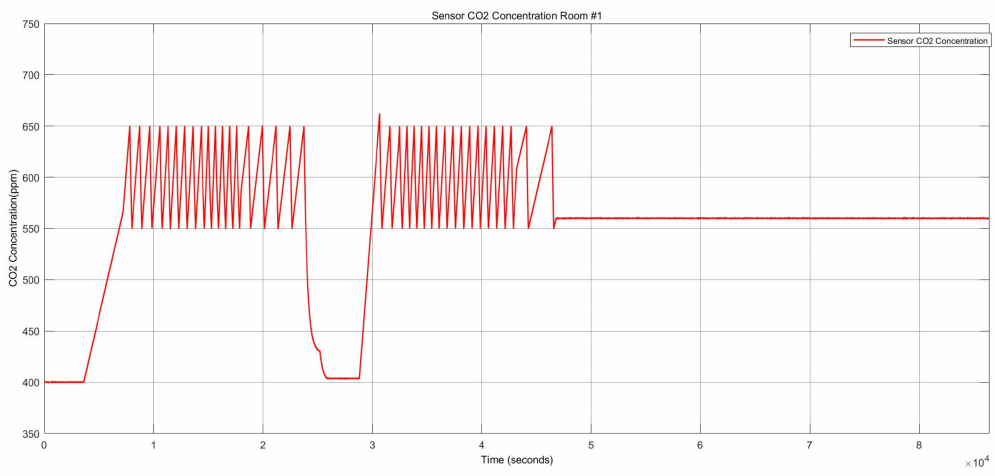
Figure 14. CO 2 concentration for the damper actuator and temperature sensor